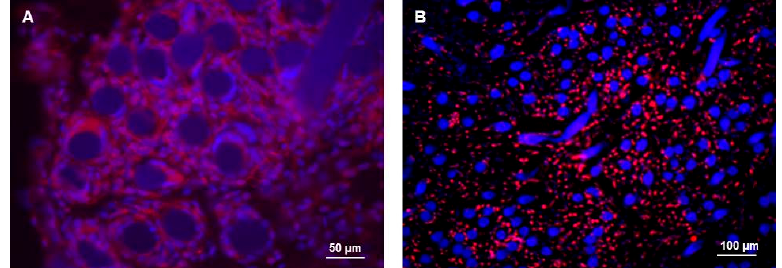
Figure 3. Immunofluorescence staining in hMSCs ( A ) before and ( B ) after implantation in a rat model. hMSCs in the scaffold interstices are identified by red positivity for CD73. Hyaluronan (HA) fibers of the scaffold are blue.